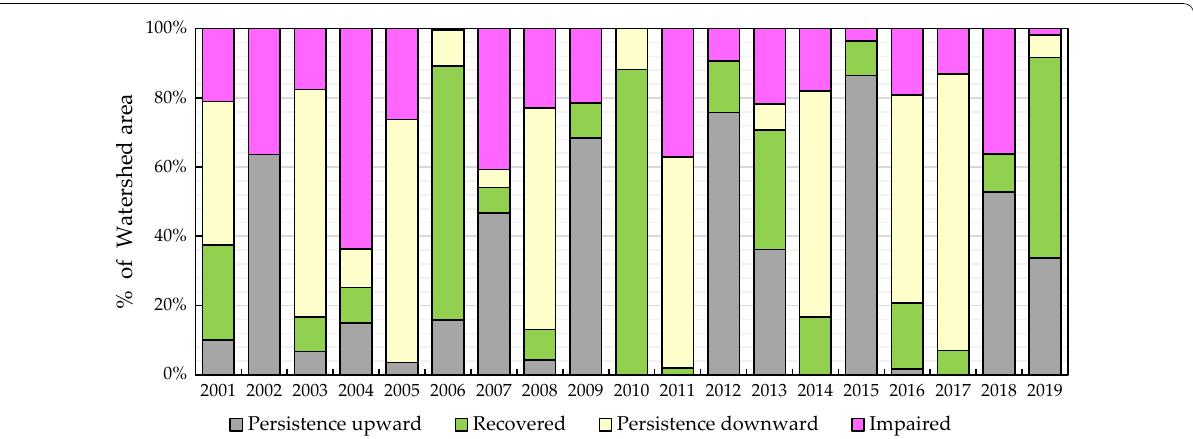
Fig. 13 Brantas watershed conditions during 2001–2020 using the change direction types of runoffs and GVF changes in every